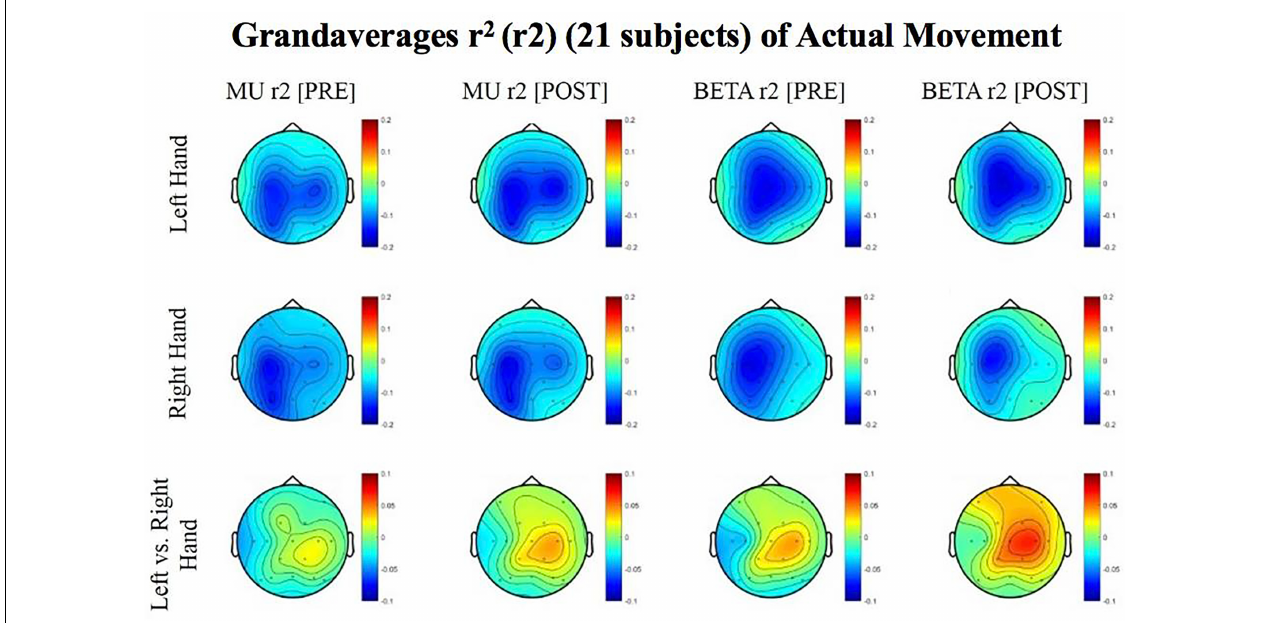
FIGURE 5 | Topoplots of grand averages for signed r-squared values at group level ( n = 21) for attempted movements. In the top two rows of topoplots, a larger negative value (blue) denotes stronger desynchronization (rest vs. left or right hand actual movement); in the bottom row of topoplots a larger positive value (red) denotes desynchronization (left vs. right hand actual movements). The mentioned distinction reflects the way in which the signed r-squared values were calculated in a rest vs. left/or right comparison, and in a left vs. right comparison. Prescreening, open-looped training (PRE) and open-looped post screening BCI training (POST) runs (color bar: [–0.2 = blue – 0.2 = red]). The majority of participants had a right lateralized lesion.